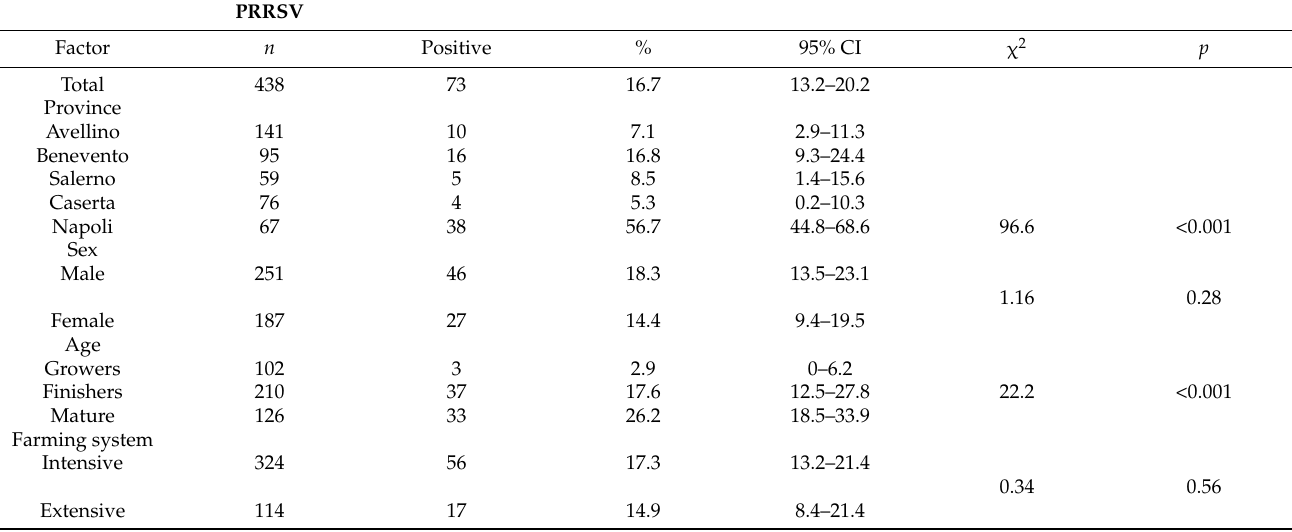
Table 3. Univariate analysis (chi-square) of a potential risk factor for PRRSV